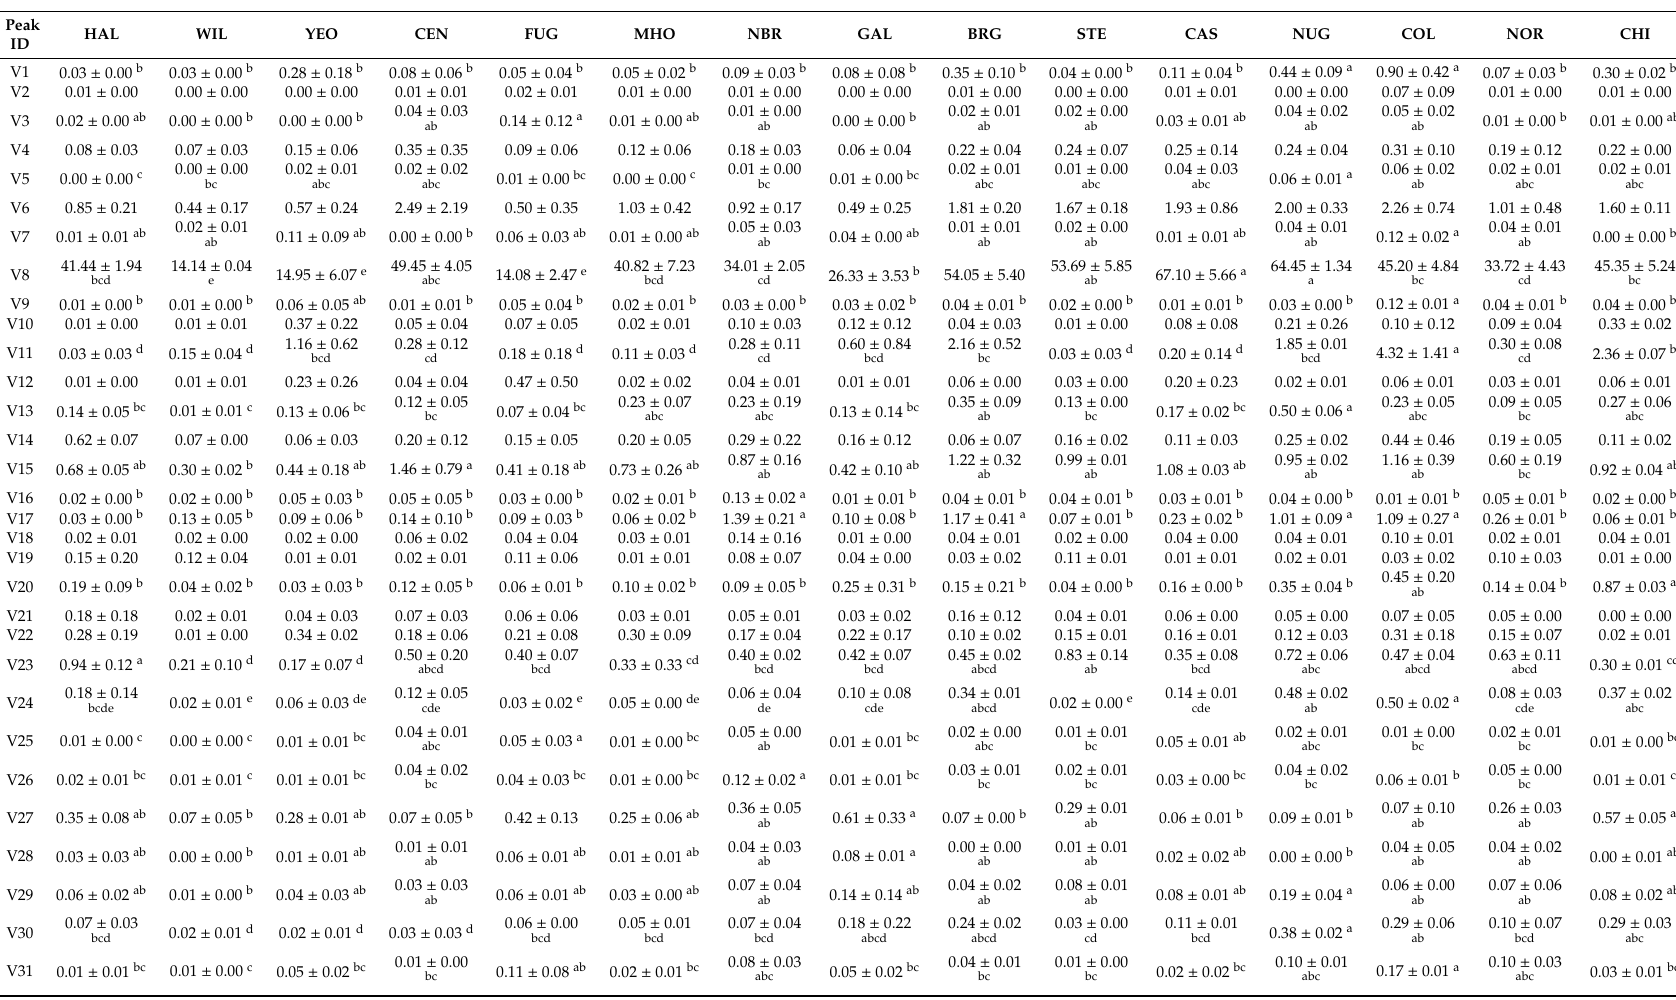
Table 4. Aroma composition (chromatographic area %, mean ± SD) of hop cones harvested from 15 varieties cultivated in the Marche region (Central